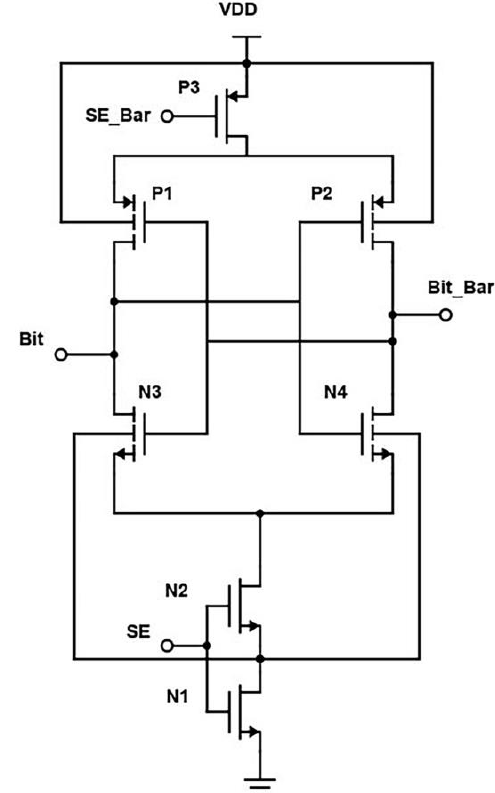
Figure 12. Modified Basic Latch Sense Amplifier Schematic.